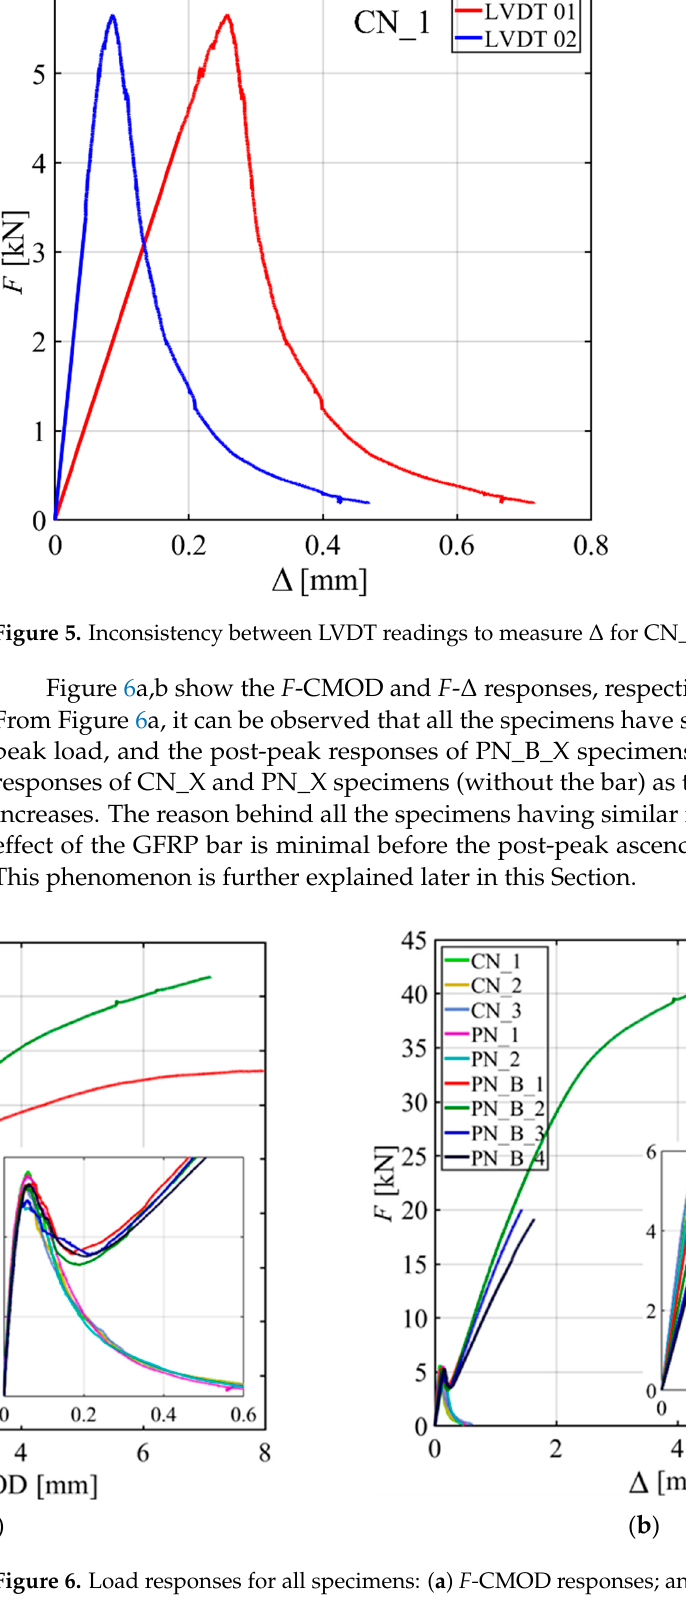
Figure 6. Load responses for all specimens: ( a ) F- CMOD responses; and ( b ) F - Δ responses.